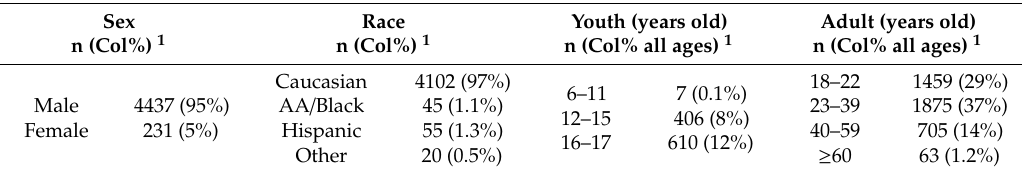
Table 2. Person-related characteristics of operators receiving o ff -road vehicle (ORV) citations in the Iowa Courts Information System (ICIS) from